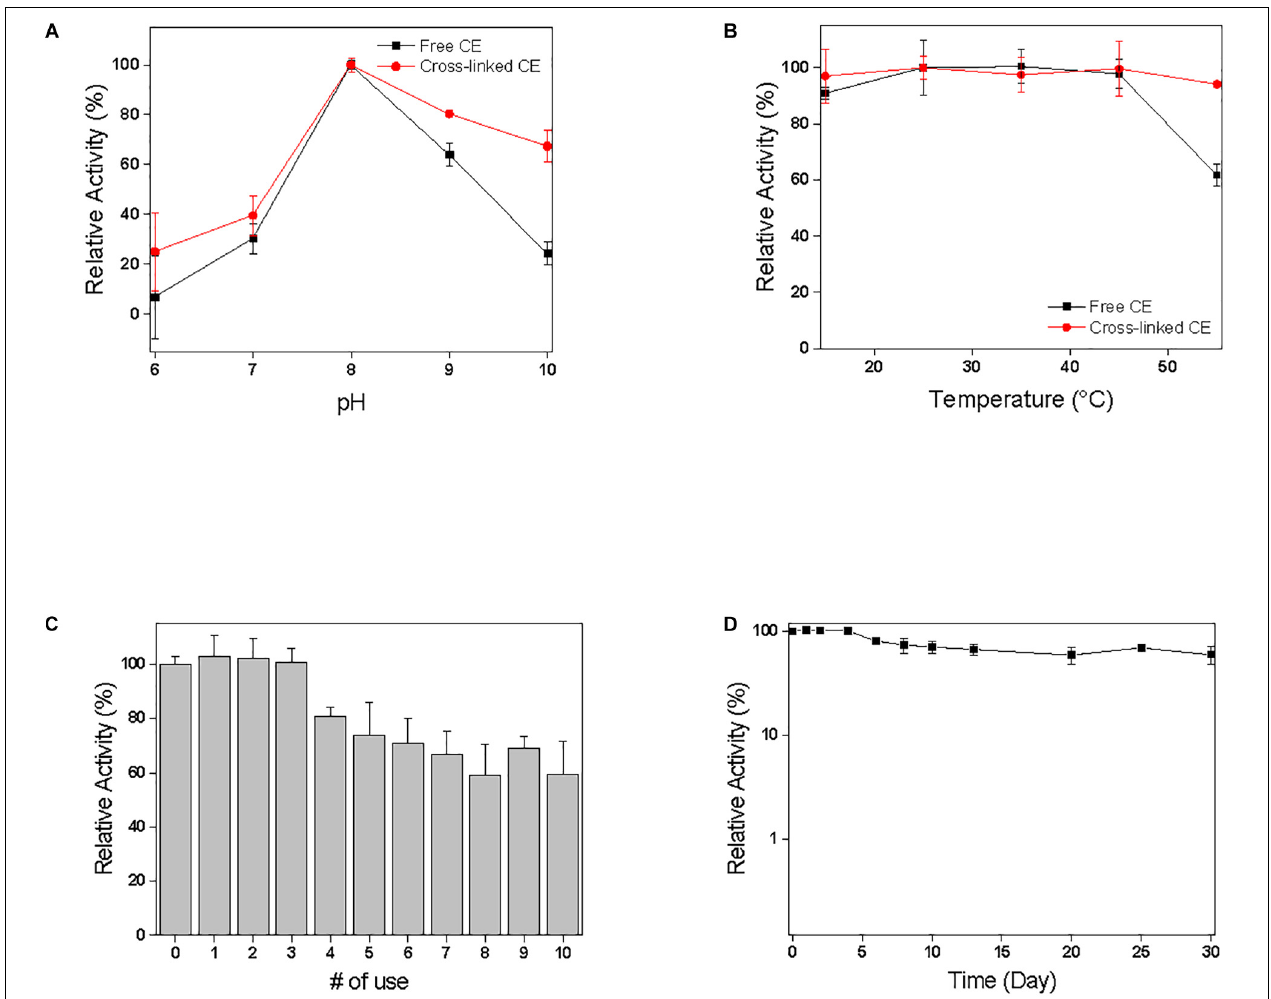
FIGURE 3 | Effect of (A) pH and (B) temperature on enzyme activity in comparison of free CE and cross-linked CE. The results were normalized with the highest value of each set being assigned the value of 100% activity. (C) Recycling and (D) Storages stability of cross-linked CE. The relative activity was calculated based on the initial activity value of